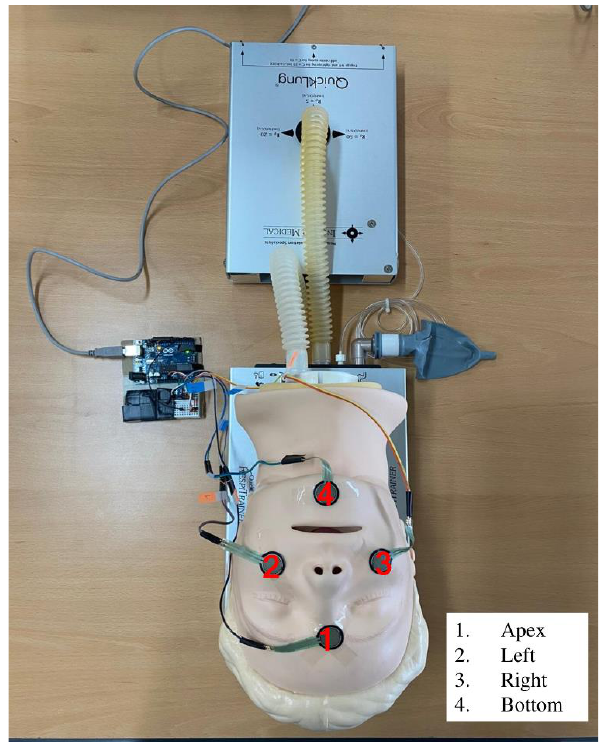
Figure 1. The four sensor attachment sites.